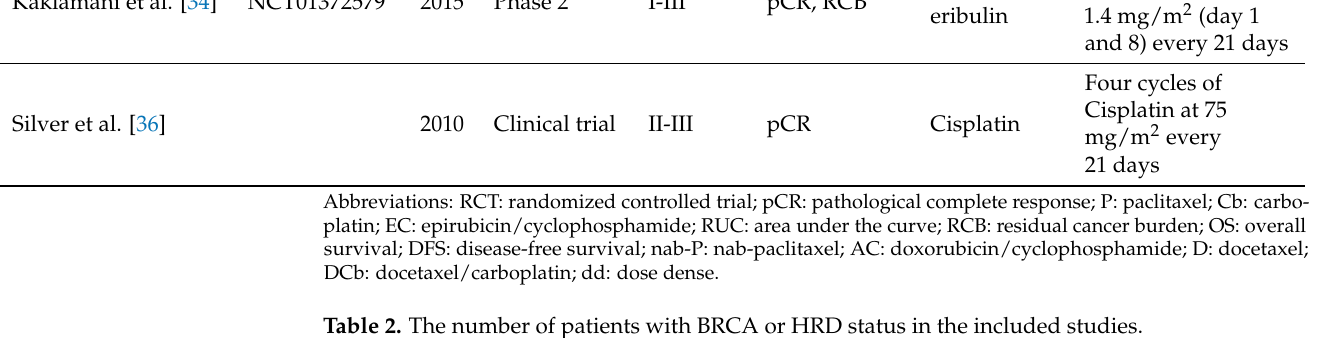
Table 2. The number of patients with BRCA or HRD status in the included